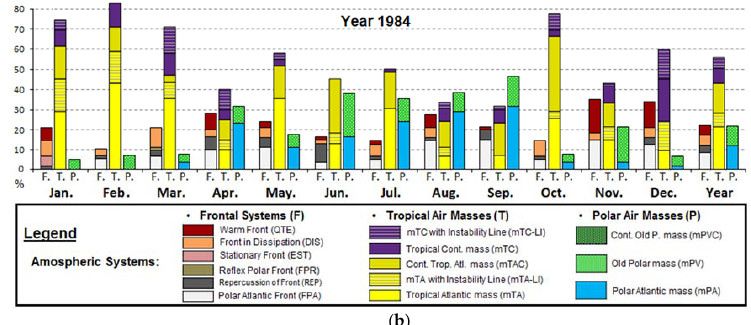
Figure 7. Atmospheric systems frequency at the monthly level in the tear ( a ) 1983; ( b ) 1984. Table 5. Atmospheric systems frequency at the monthly level in the year 1984.